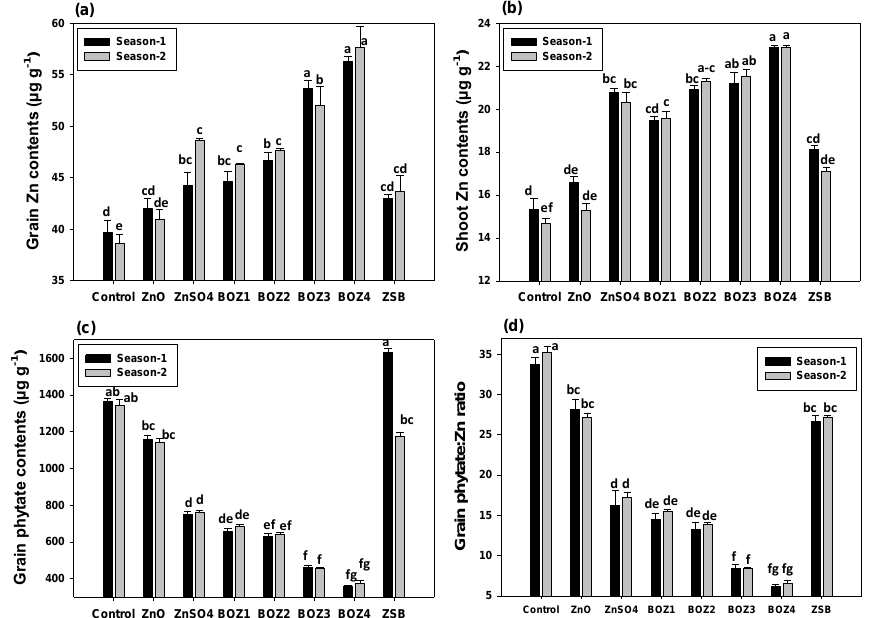
Figure 1. E ff ect of di ff erent Zn sources on gain Zn contents ( a ), shoot Zn contents ( b ), gain Figure 1. Effect of different Zn sources on gain Zn contents ( a ), shoot Zn contents ( b ), gain phytate contents ( c ) and grain phytate:Zn molar ratios ( d ) of maize grown in two different cropping seasons (Data are shown as mean of three replications. Means followed by same letter(s) are not significantly